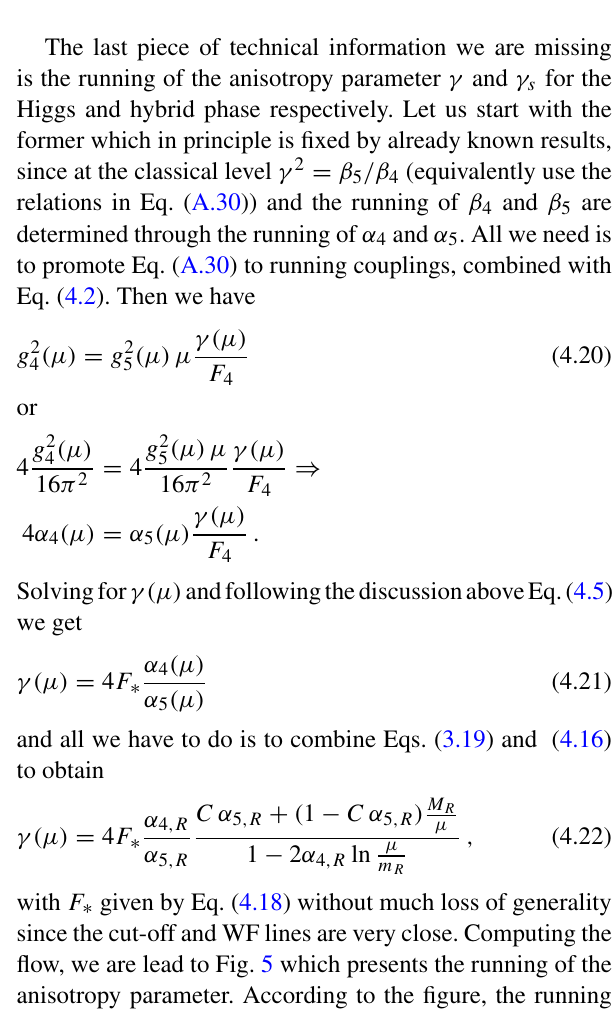
Fig. 6 Therunningoftheanisotropy γ s (μ) asafunctionofthedynam- ical scale. The green bullet represent the scale μ 2 where the anisotropy becomes γ s (μ 2 ) = 1 while the yellow one the scale μ ∗ at which γ (μ ∗ ) ≡ γ ( μ ∗ ) . The black bullet (Gaussian fixed point), shows the s limit μ → ∞ where γ s → 0, corresponding to the minimum value of the anisotropy. The behaviour of γ s stays always similar to the bulk- driven phase transition of Fig.